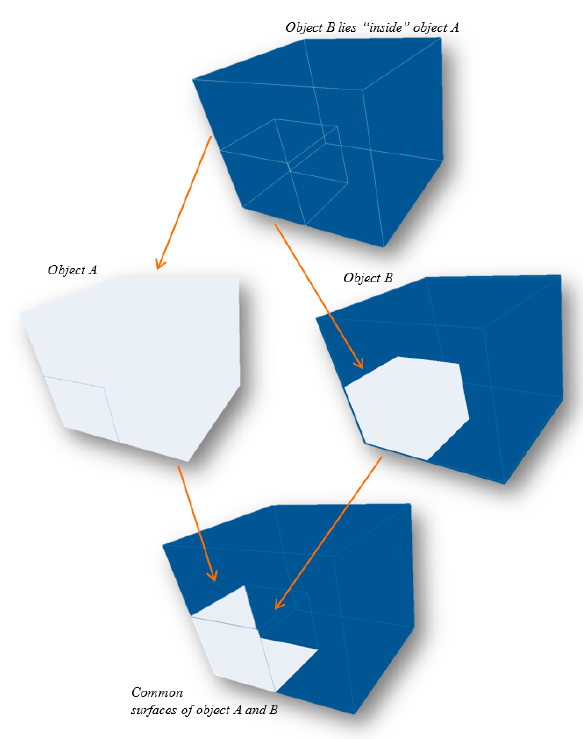
Figure 11. Containment in CACC.